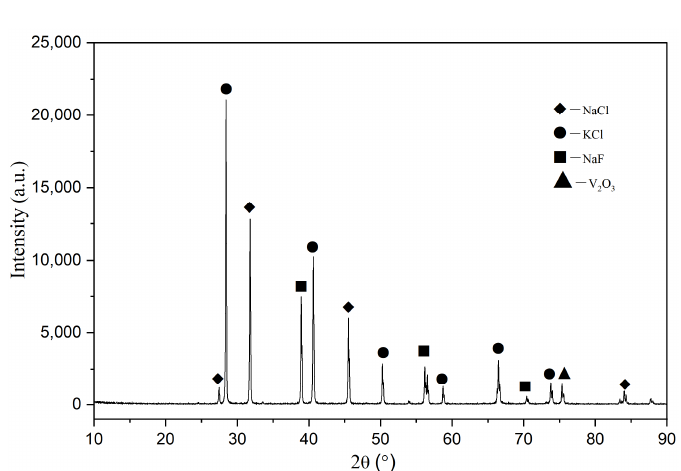
Figure 2. XRD spectrum of the NaCl-KCl-NaF-V 2 O 3 molten salt system.